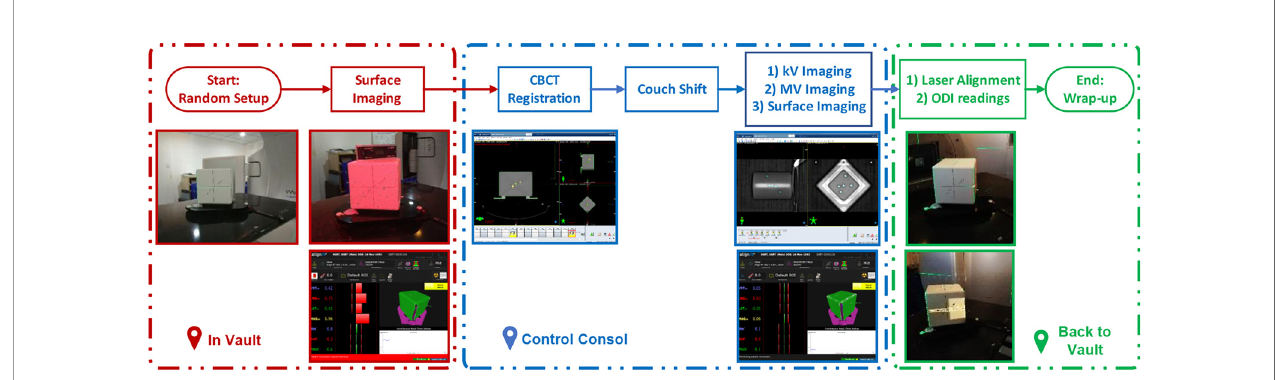
FIGURE 2 | Step-by-step procedure of the streamlined QA program: from cube set-up to